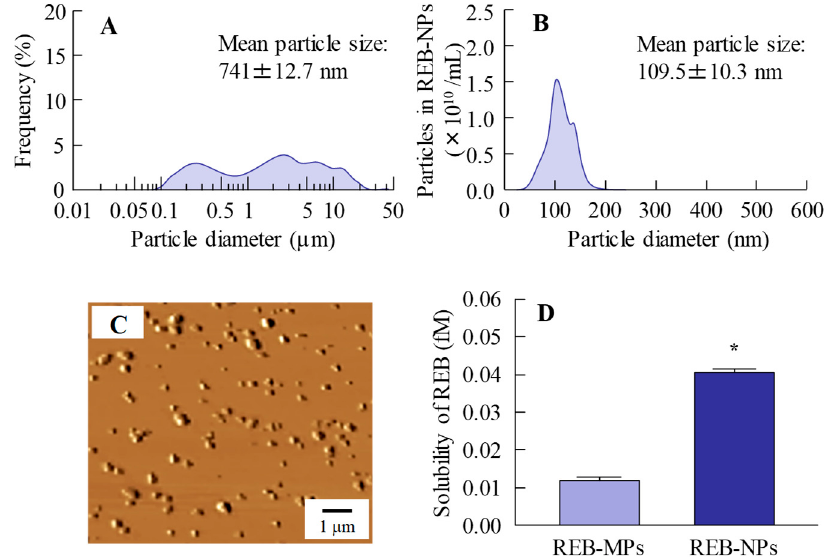
Figure 1. Characterization of the particle size, shape and solubility of rebamipide solid microparticles (REB-MPs) and nanoparticle (REB-NPs)-based ophthalmic formulation. ( A ) REB-MPs size by laser di ff raction measurement. ( B ) REB-NPs size by dynamic light scattering measurement. ( C ) AFM image of REB-NPs. ( D ) Drug solubility in REB-MPs and REB-NPs. n = 6. * P < 0.05, vs. REB-MPs. 99.92% of the rebamipide existed in the solid form in REB-NPs, and the mean particle size was 109.5 nm.